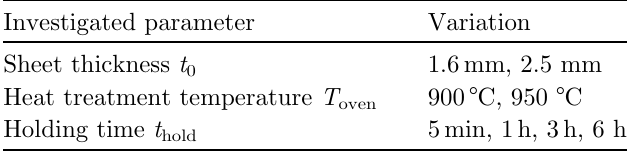
Table 2. Investigated in fl uencing